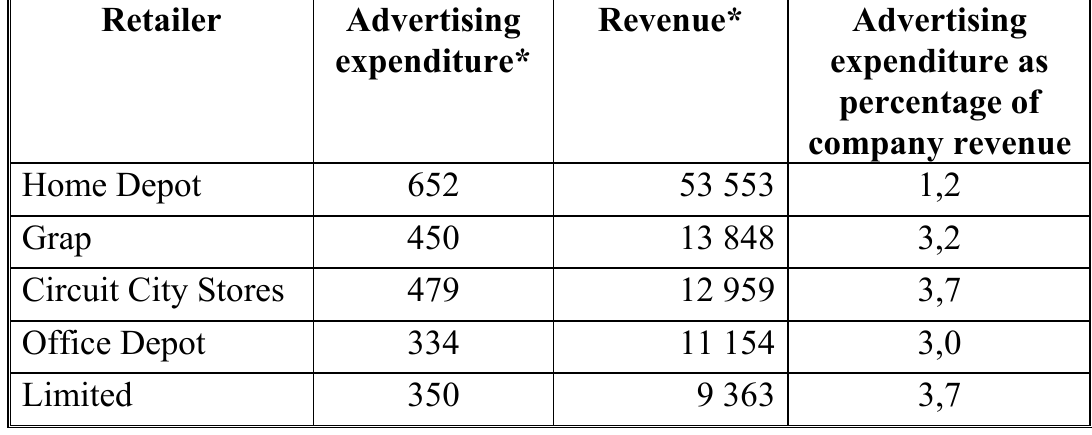
Advertising expenditure as percentage of company revenue for selected USA speciality retailers: 2000